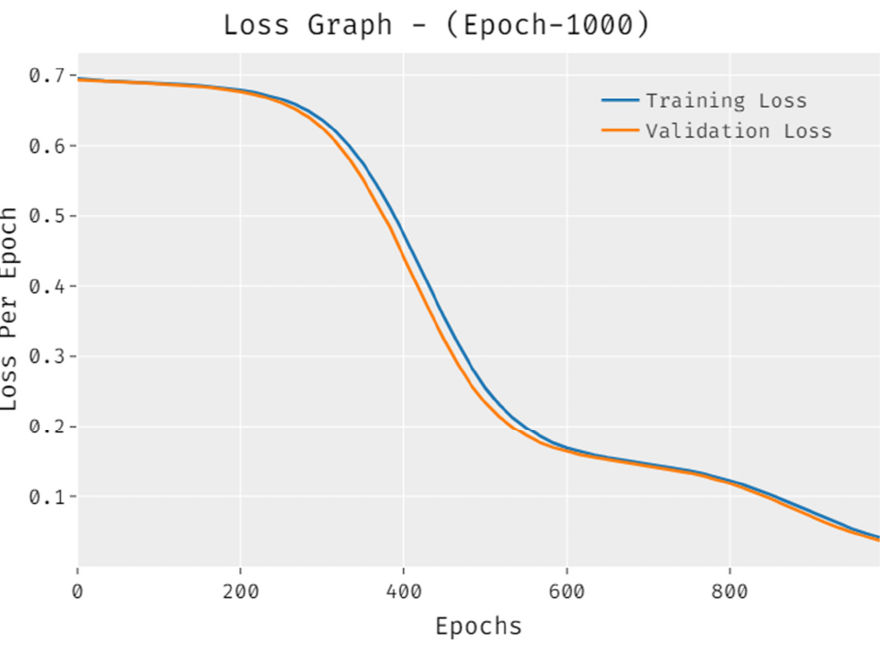
Figure 8. Loss graph analysis of DLSODC ‐ GWM technique under 1000 epochs.